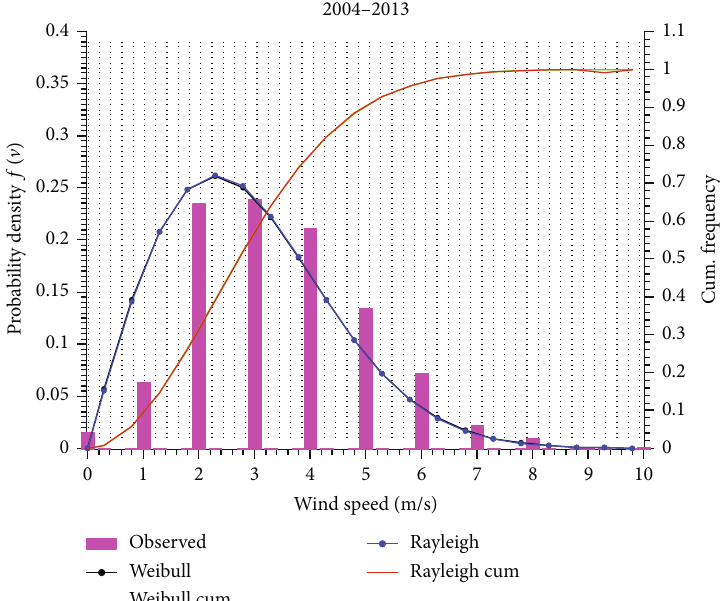
Figure 6: Observed histogram, Weibull, and Rayleigh probability and cumulative curves for years 2004-2013 (Tables 1 – 12 in Supplementary Materials).